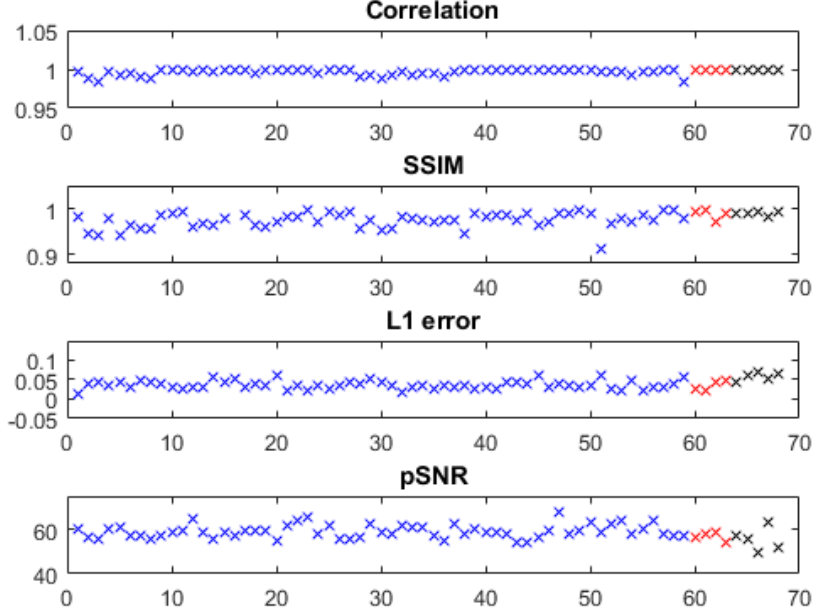
Figure 2. Quantitative evaluation on predicted water images. Metrics of the knee, arm, and foot/ankle images are marked with blue, red, and black, respectively. (1) Using the models trained with only knee images, water-fat separation was performed on knee images from 59 subjects, foot/ankle images from 5 subjects, and arm images from 4 subjects. Overall, the correlation coefficient was between 0.9833 and 1.0000 with mean/std of 0.9969 ± 0.0040, the l 1 error was between 0.0346 and 0.0648 with mean/std of 0.0381 ± 0.0122, the SSIM was between 0.9994 and 1.0000 with mean/std of 0.9740 ± 0.0207, and the pSNR was between 49.6049 and 67.5389 with mean/std of 58.6876 ± 3.2359.